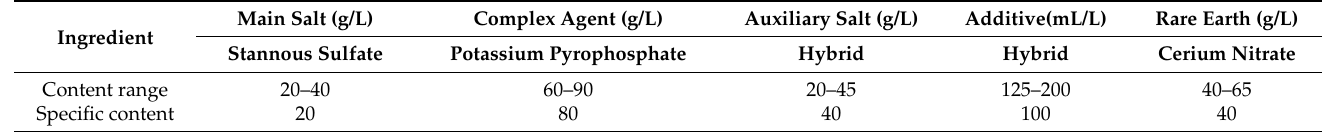
Table 1. Plating solution